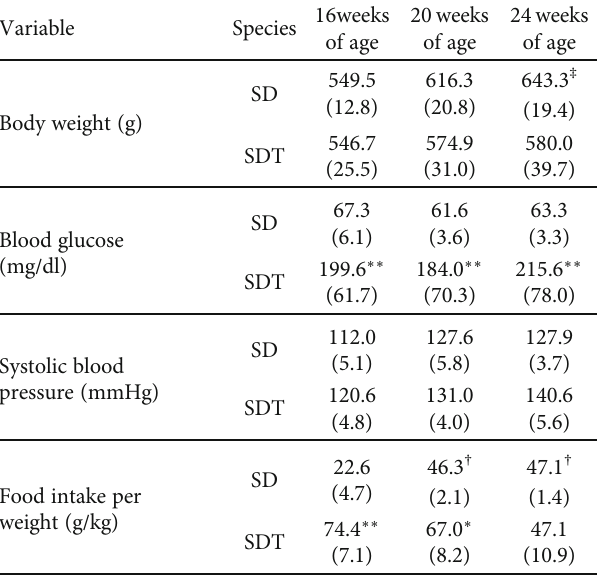
Table 1: Time-related changes in body weight, blood glucose, systolic blood pressure, and food intake per weight.